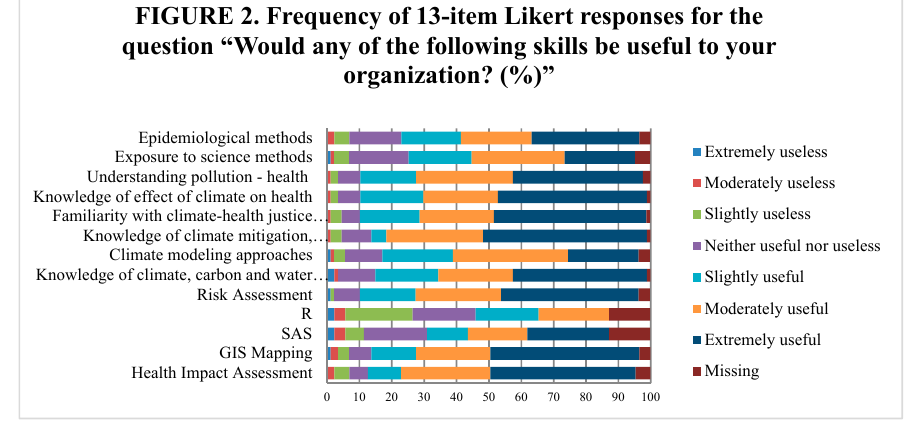
Figure 2. Frequency of 13-item Likert responses for the question “Would any of the following skills be useful to your organization?” (%). R and SAS refer to statistical analysis software.